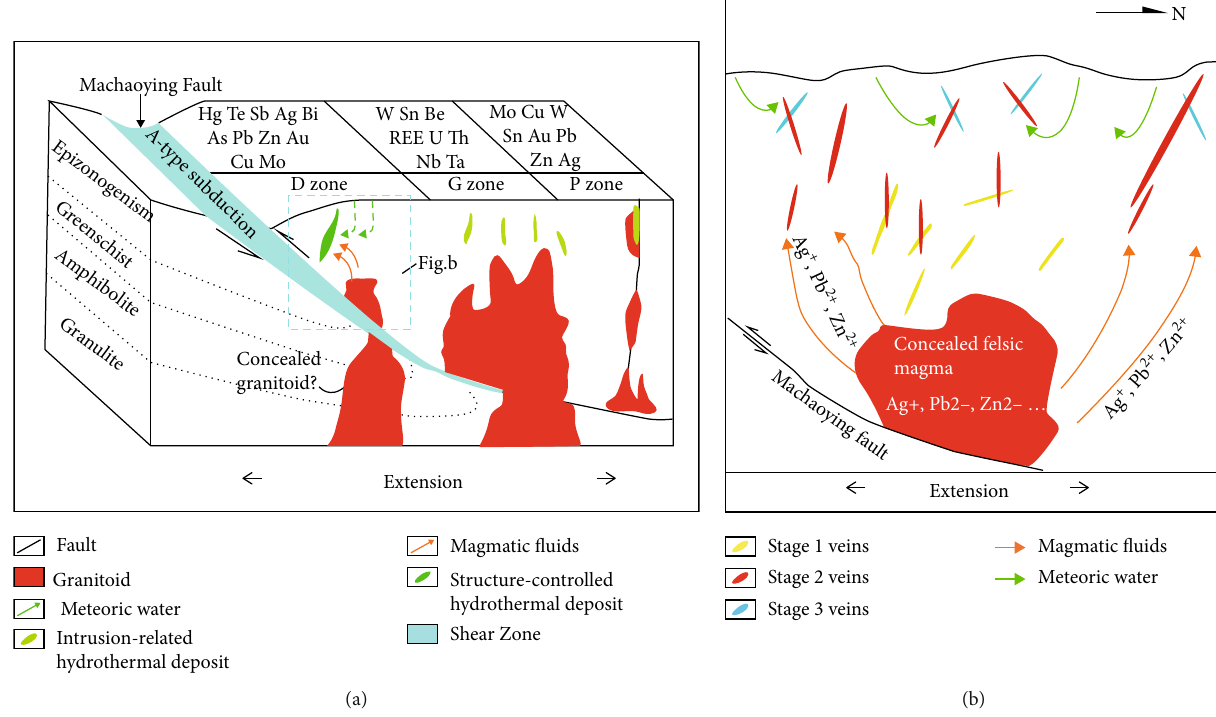
Figure 14: Metallogenic model for the Shagou (Xiayu) Ag – Pb – Zn ore fi eld (modi fi ed after [67, 68]) (a). The genetic model for Ag-Pb-Zn vein formation at Longmendian deposit (modi fi ed after [42, 59]) (b). D: hydrothermal lode deposits; G: granites and their related deposits; P: porphyries, breccia pipes, their related